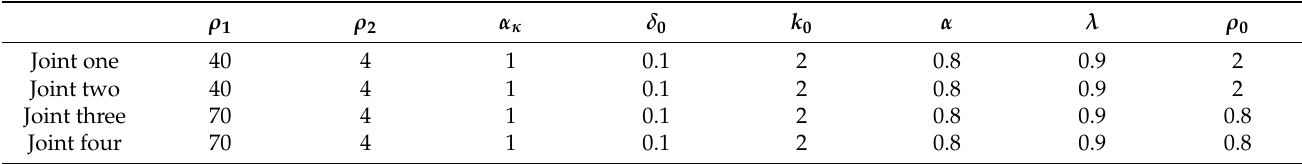
Table 5. Parameters list of dynamic fractional-order nonsingular terminal super-twisting sliding mode (DFONTSM-STA) control.